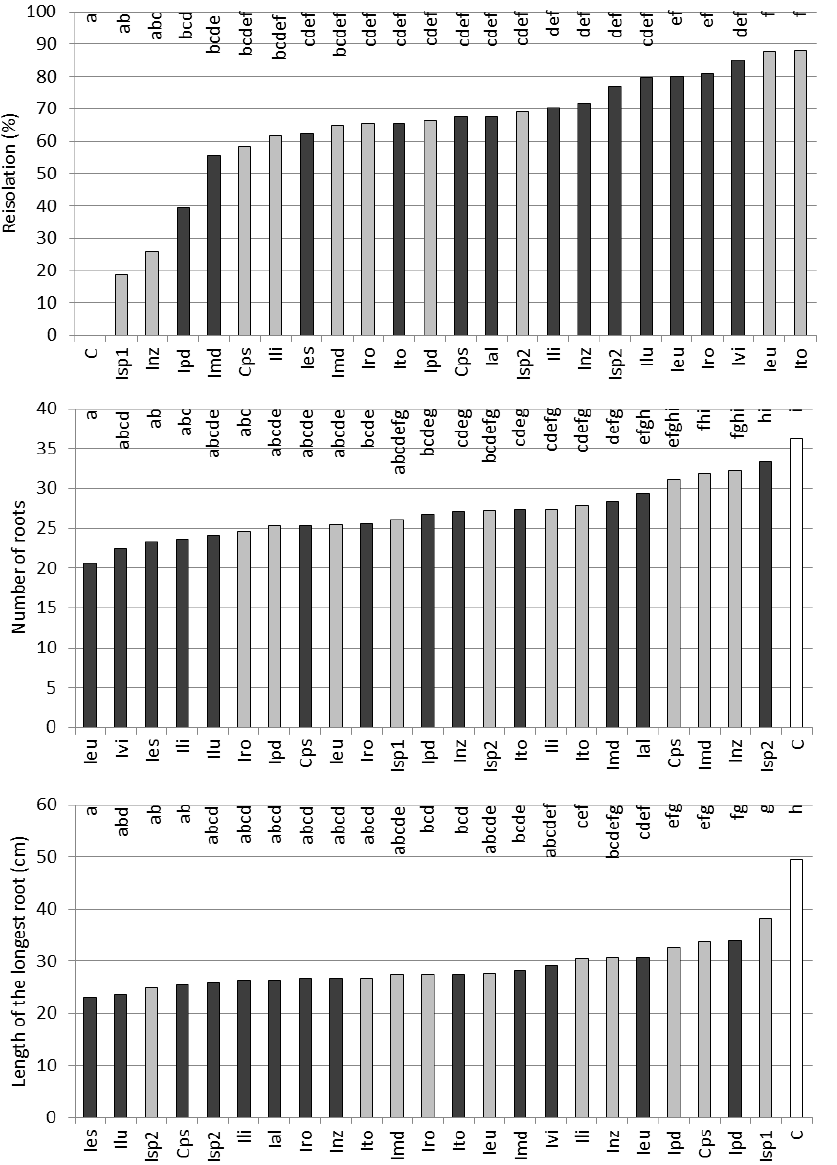
Figure 1. Comparison among Ilyonectria spp. isolates from grapevines (black bars) and from other hosts (grey bars) for their effect on grapevine rootstock 1103P in: frequency of reisolation; number of roots; length of the longest root; root dry weight; number of shoot nodes; shoot length; shoot dry weight. Bars affected by the same letter do not differ statistically according to Tukey’s test ( P =0.05). C, Control (white bars); Cps, “ C .” pauciseptatum (average of three isolates from grapevine and one isolate from another host); Ial, I. alcacerensis (two isolates from grapevines); Ies, I. estremocensis (four isolates from grapevines); Ieu, I. europaea (two isolates from grapevines and two from other hosts); Ili, I. liriodendri (four isolates from grapevines and three from other hosts); Ilu, I. lusitanica (one isolate from grapevines); Imd, I. macrodidyma (four isolates from grapevines and two from other hosts); Inz, I. novozelandica (four isolates from grapevines and one from another host); Iro, I. robusta (three isolates from grapevines and eight from other hosts); Isp1, Ilyonectria sp1 (one isolate from olive); Ipd, I. pseudodestructans (two isolates from grapevines and two from other hosts); Isp2, llyonectria sp2 (two isolates from grapevines and two from other hosts); Ito, I. torresensis (four isolates from grapevines and two from other hosts); Ivi, I. vitis